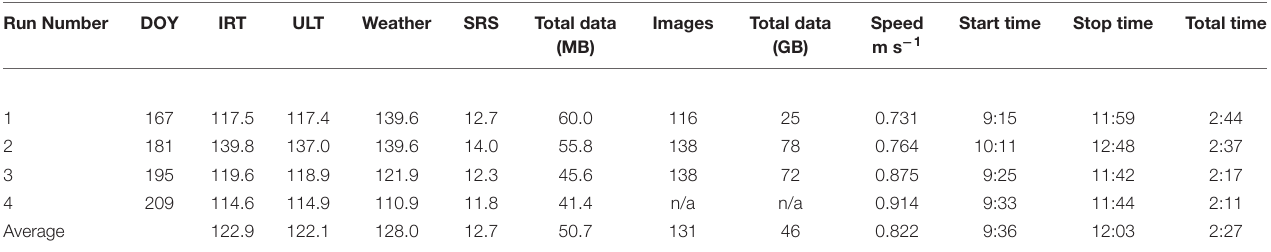
TABLE 2 | Proximal sensing carts (PSC) data collections listed by the run number and day of year (DOY) of the collection. Run